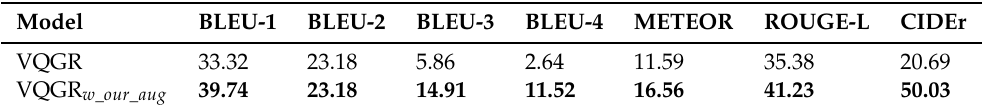
Table 3. Evaluation results on the validation set of the VQG dataset provided in the ImageCLEF 2020 VQA-Med challenge. VQGR trained on the original training datatset. VQGR w _ our _ aug trained on the augmented data obtained by our data augmentation technique.